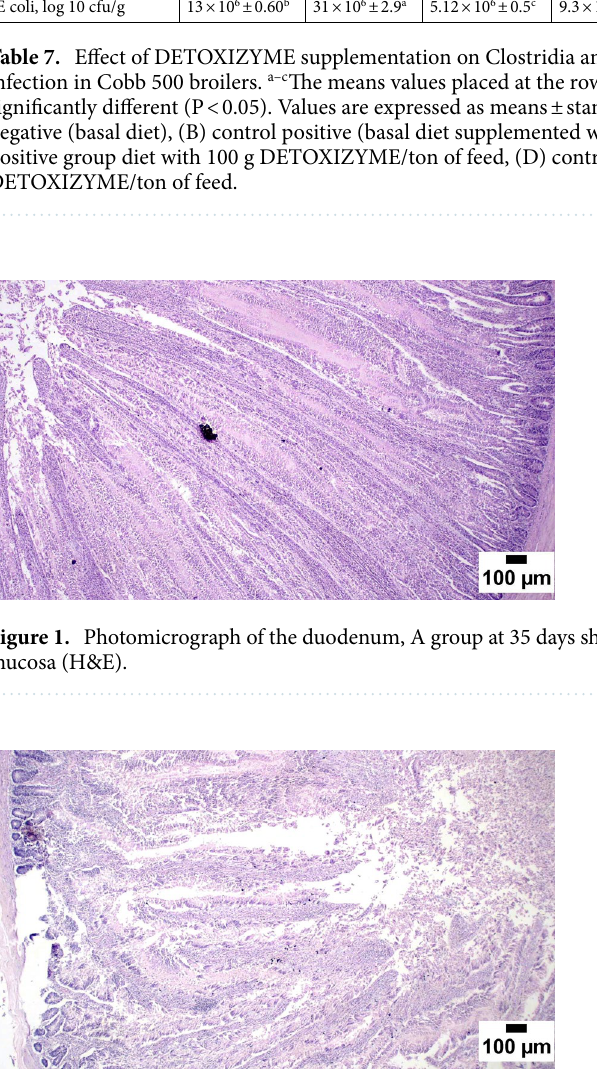
Figure 2. Photomicrograph of the duodenum, B group at 35 days showing marked enteritis with numerous inflammatory cells infiltration in the lamina propria and submucosa.